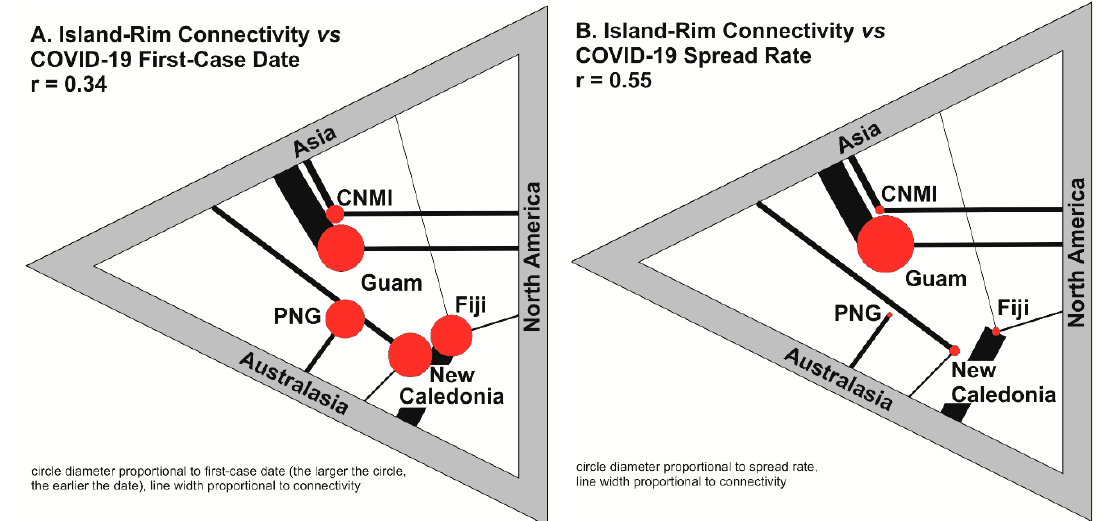
Figure 1. Island-rim connectivity vs. COVID-19 first-case date: ( A ) the correlation between first-case dates and connectivity; ( B ) the correlation between connectivity and spread rate. Table 1. Pacific Island group connectivity, the earliest reported COVID-19 case, and the spread rate. Earliest Flights from Flights from Flights from Spread Rate Airport (Pacific Island Group) COVID-19 Asia Americas Australasia (Cases Per Case Date